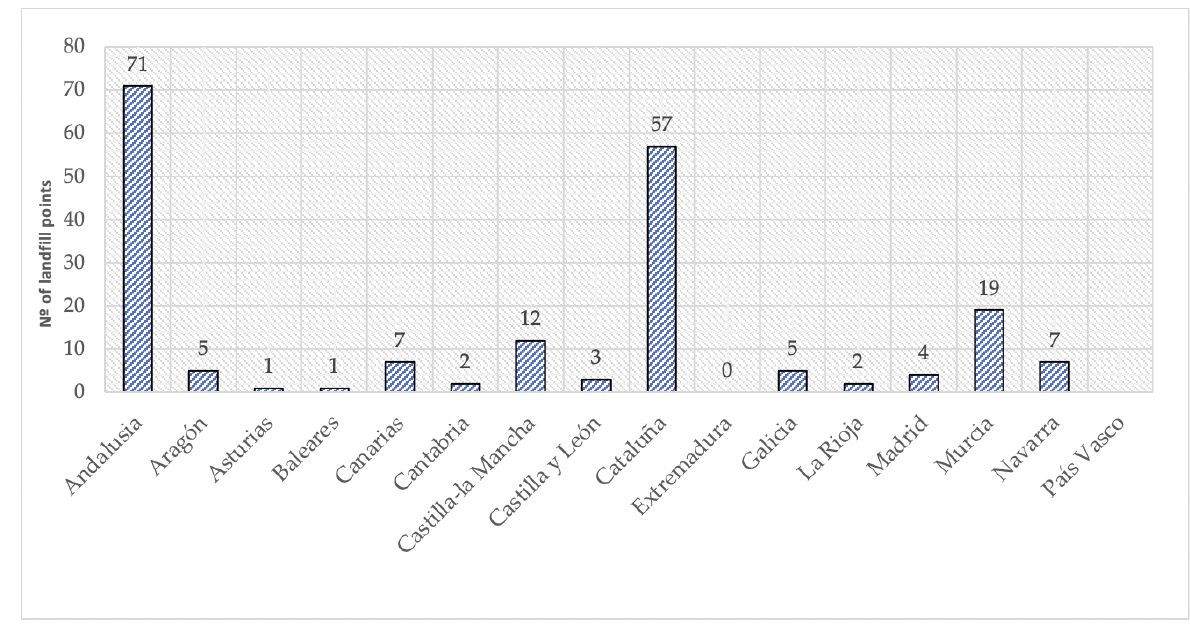
Figure 5. Number of landfill points for C & D waste by autonomous communities. Source: own elaboration with data collected from [35].